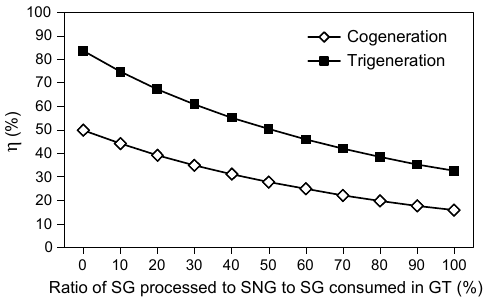
Figure 5. System cogeneration and trigeneration average efficiencies as a function of the SNG production rate.